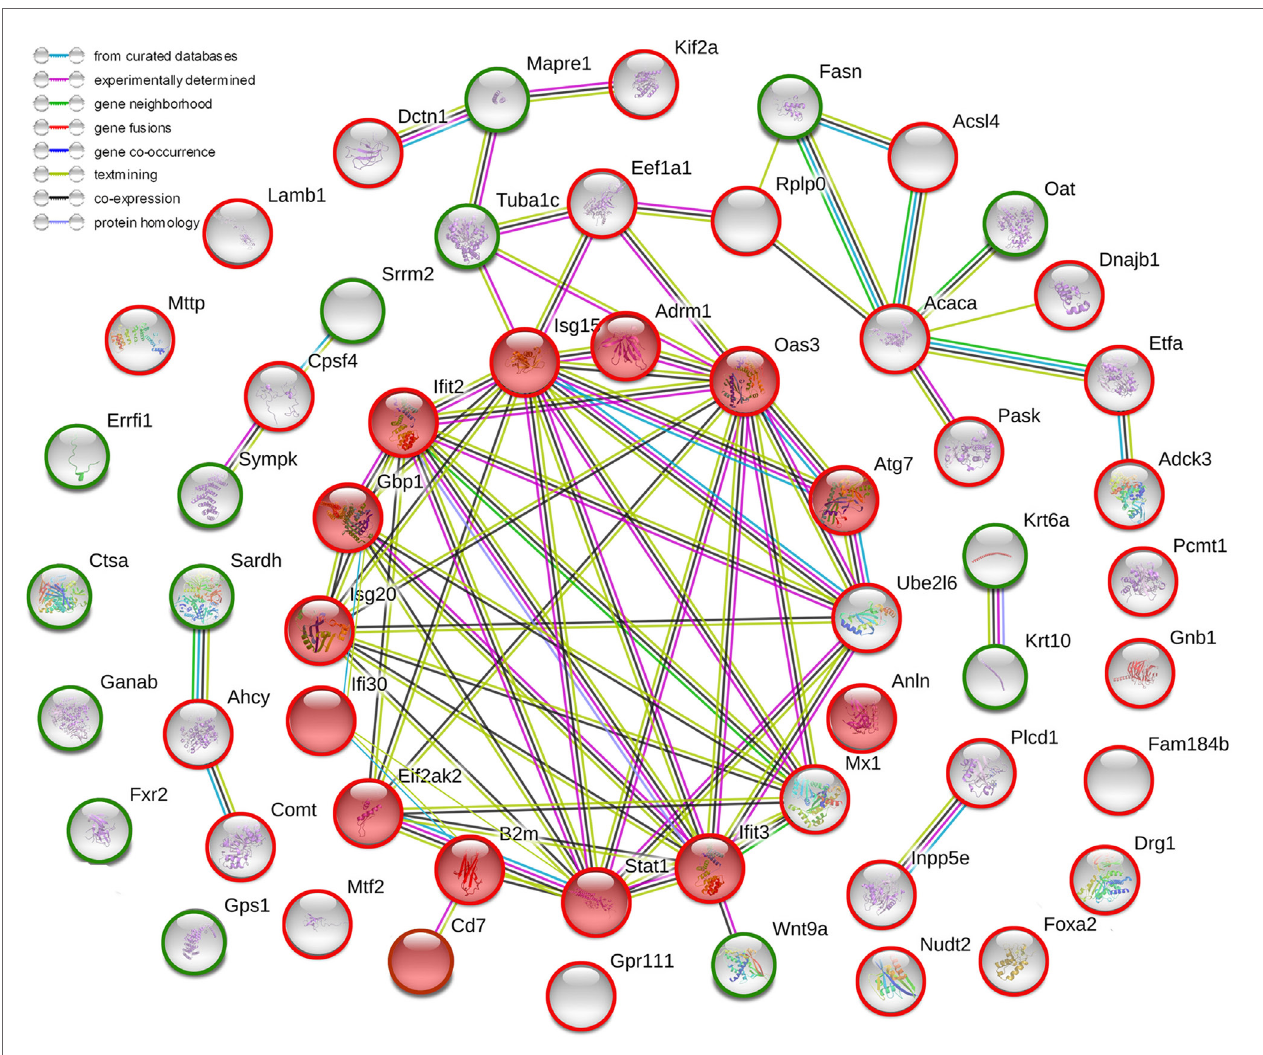
FigUre 2 | The current interactions of differentially expressed proteins in liver tissues of ConA-induced hepatitis mice compared with that of normal mice. The red nodes represented the functional enrichments of proteins in immune system. The red circles represented upregulated proteins while the green circles represented downregulated proteins. The network was made on the basis of